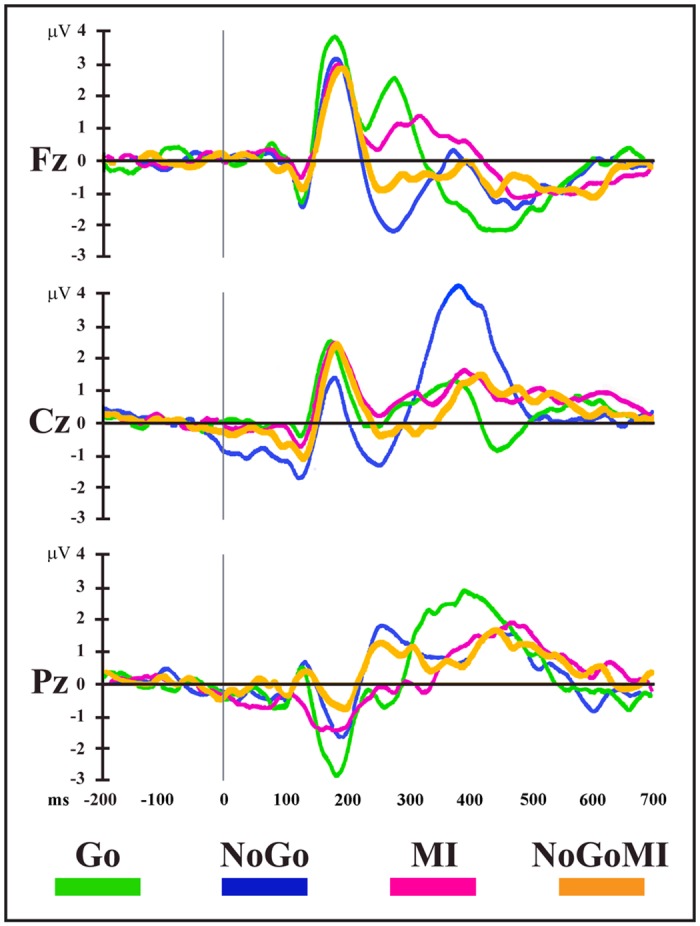
Event related potential (ERP) waveforms.Group-averaged (n = 15) stimulus-locked ERP waveforms (plotted as voltage in μV in function of time in ms, stimulus onset: 0 ms) for the four experimental conditions from Fz, Cz and Pz electrodes. MI: Motor Imagery; NoGoMI: NoGo Motor Imagery.